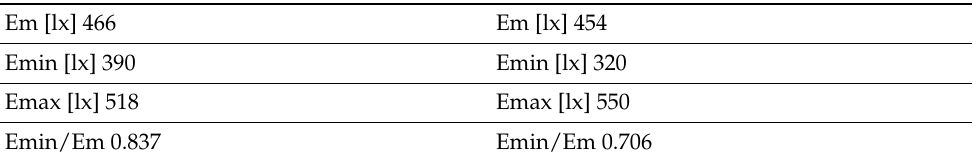
Table 2. Superficial lighting vs. linear lighting. Calculations results with DianaX by Lorenzo Muro and Joseph Cabeza-Lainez.